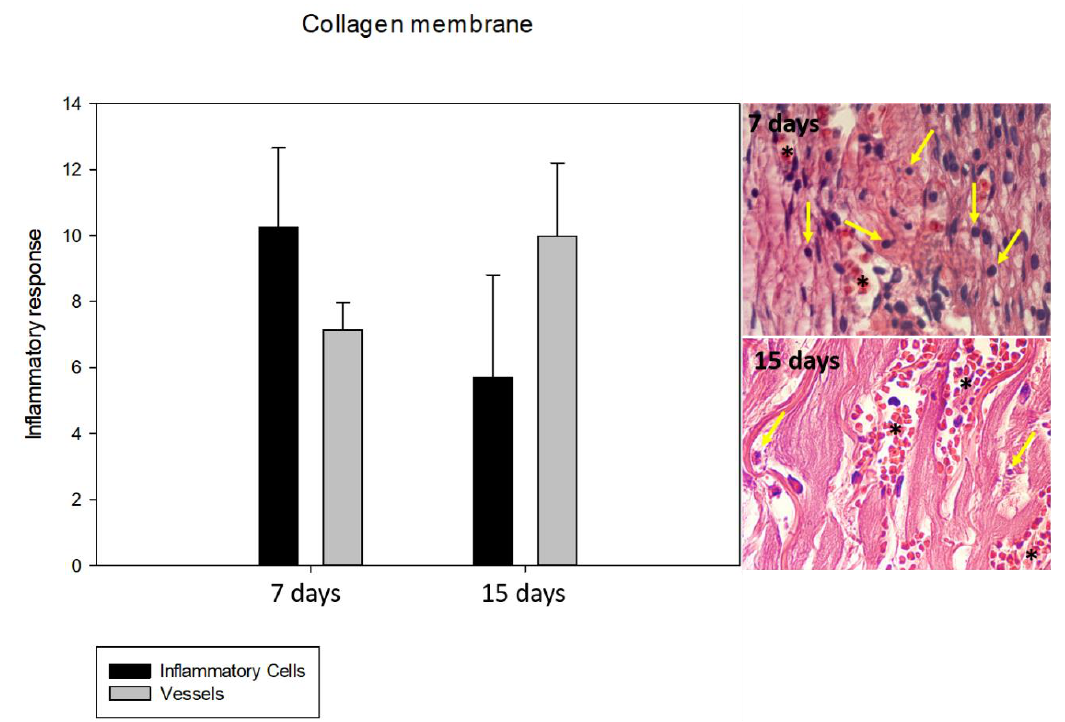
Figure 2. Graph and photomicrographs (×100) demonstrating the average number of inflammatory cells and vessels in the BG group during the periods analyzed. Regarding the biological behavior of the collagen membrane, there was a decrease in the number of inflammatory cells and an increase in the number of vessels. Asterisks (*) represent regions of bone stumps.